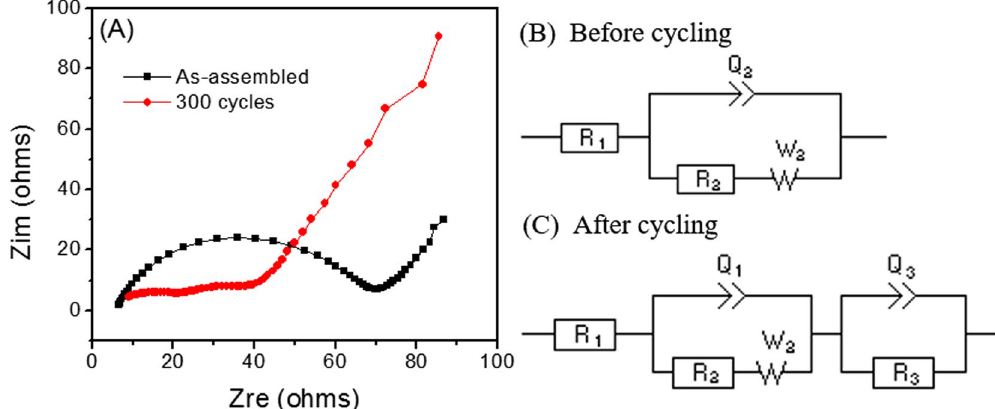
Figure 7. ( A ) Nyquist plots of the ECF under different cycling conditions: as-assembled cycle and after 300 cycles. Equivalent circuits for fitting Nyquist plots ( B ) before and ( C ) after cycling. R 1 : the internal series